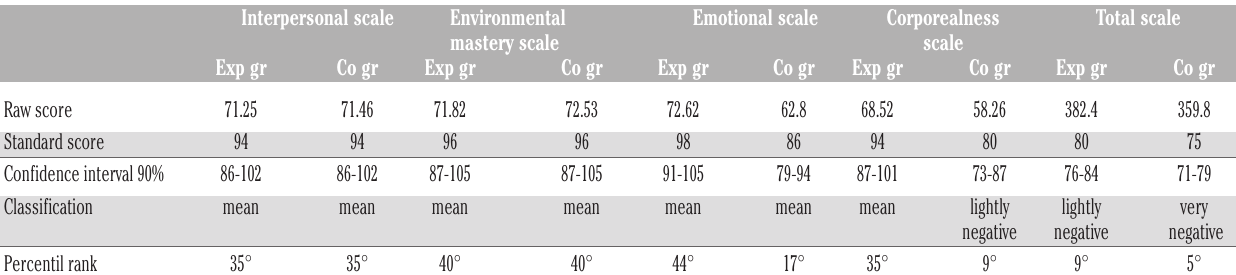
Table 1. The TMA (test multidimensionale dell'autostima) scores of the experimental group (N=40) and the control group (N=30). Interpersonal scale Environmental